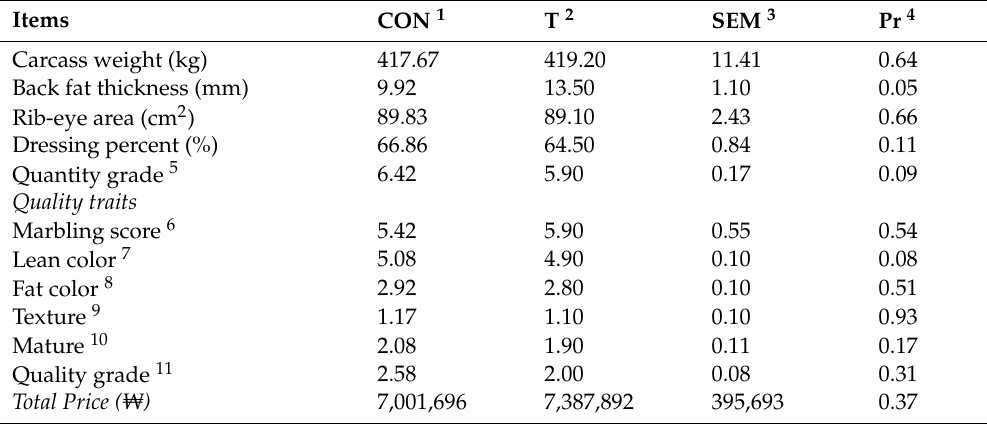
1 CON: Hanwoo steer fed rice straw + concentrate, 2 T: Hanwoo steer fed WCBS + concentrate, 3 Standard error